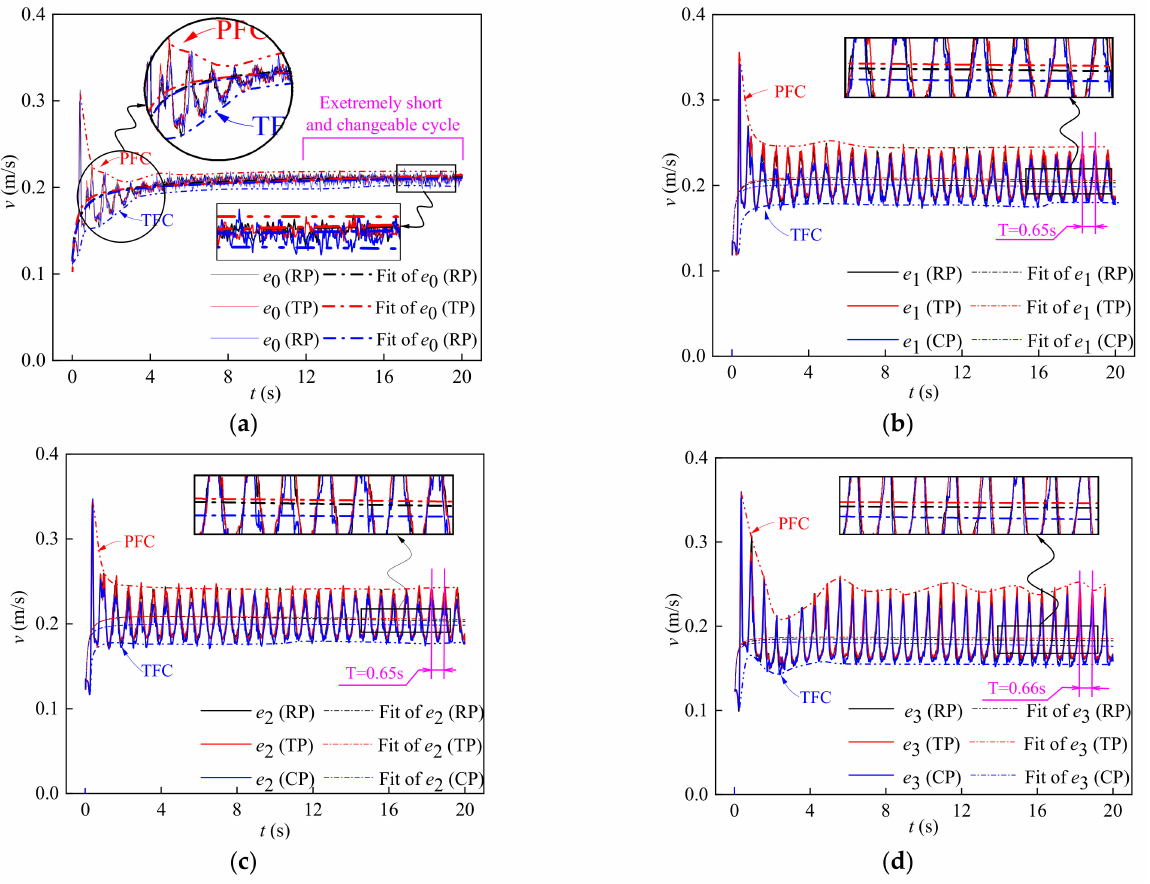
Figure 9. The average velocity of particles with different shapes in a rotating device under the same eccentricity at 45 rpm. ( a ) Eccentricity of e 0 ; ( b ) eccentricity of e 1 ; ( c ) eccentricity of e 2 ; ( d ) eccentricity of e 3